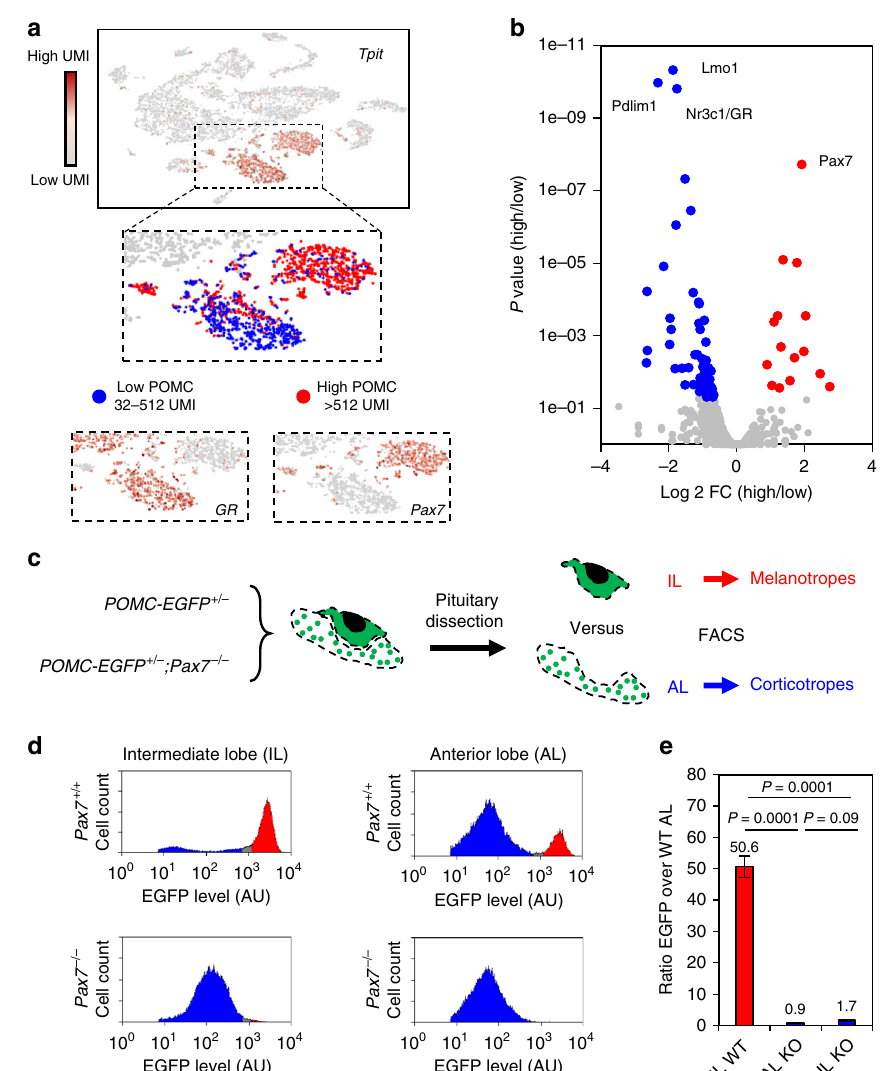
Fig. 3 Pax7 implements melanotrope features onto a shared pro-opiomelanocortin (POMC) cell identity. a t-Distributed stochastic neighbor embedding (t- SNE) map of adult pituitary cells colored for expression of the POMC lineage regulator Tpit (Tbx19). Enlarged panels showing two clusters of POMC cells with high and low POMC levels, melanotropes expressing Pax7, and corticotropes expressing GR. b Volcano plot showing differential transcription factor gene expression ( p value versus log 2 fold change (FC)) between the high versus low POMC-expressing cells. GR and Pax7 are highlighted. c Experimental scheme to assess Pax7 dependence of melanotrope phenotypic features. Transgenic mice expressing POMC-EGFP (enhanced green fl uorescent protein) were crossed into Pax7 − / − mice and compared to wild-type (WT). The two pituitary lobes were dissected for each genotype and analyzed by fl uorescence-activated cell sorting (FACS). d Representative FACS pro fi les showing cell populations with different POMC-EGFP transgene levels in intermediate (IL) and anterior lobes (AL) of WT ( n = 5) and Pax7 KO (knockout) ( n = 3) pituitaries. Blue and red shading labels low and high EGFP levels, respectively. e Bar graph showing ratios of EGFP signals in WT IL, Pax7 KO AL, Pax7 KO IL compared to WT AL. The analyses included fi ve WT and three Pax7 KO replicates. P values were computed using unpaired two-sided t Pcsk2 (Fig. 5i). This con fi rms that Pax7 functionally requires Tpit to establish melanotrope identity.